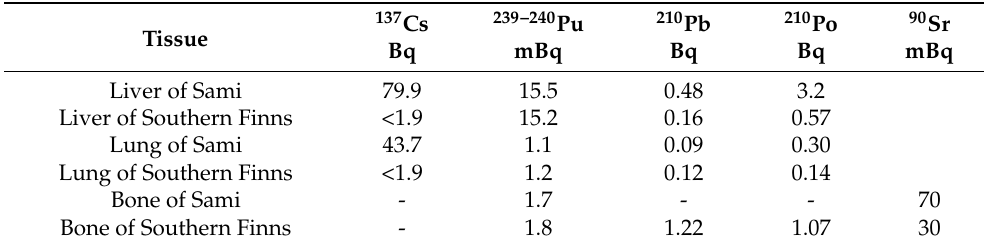
Table 2. Concentrations (Bequerels) of radioactive cesium ( 137 Cs), plutonium ( 239 – 240 Pu), lead ( 210 Pb), polonium ( 210 Po), and strontium ( 90 Sr) in liver, lung and bone tissues (post-mortem samples) in the 1970s [31]. 137 Cs 239–240 Pu 210 Pb Tissue Bq mBq Bq Bq mBq Liver of Sami Liver of Southern Finns Lung of